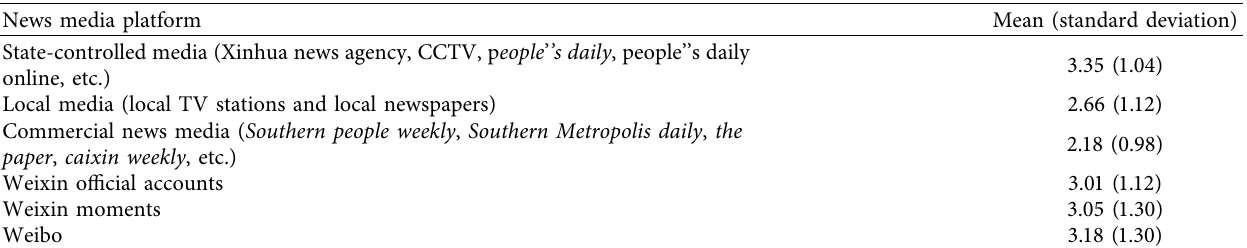
Table 8: Mean of the audience’s exposure to COVID-19 vaccine information through news media platforms. News media